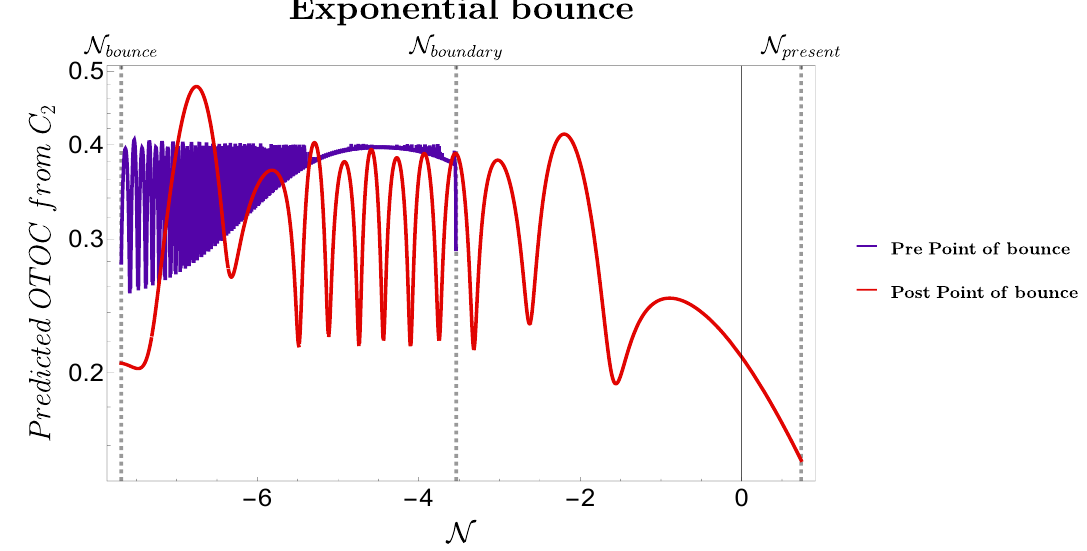
Figure 41: Predicted OTOC from geodesically weighted complexity inside bouncing region with respect to number of